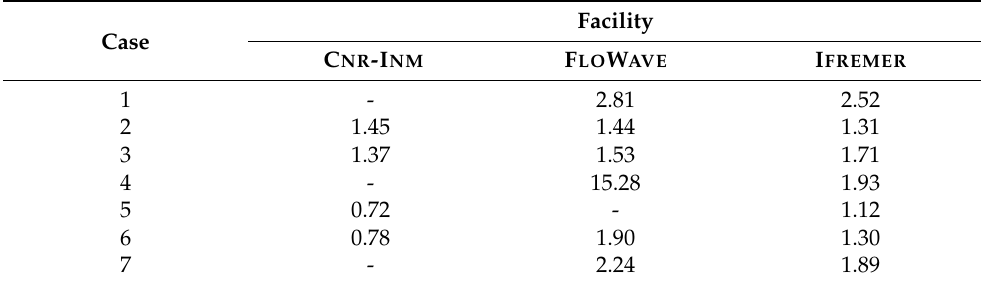
Table 10. Combined uncertainty for torque as percentage of mean value based on the case number for each facility [%]. Current-only cases at C NR -I NM have no repeats.